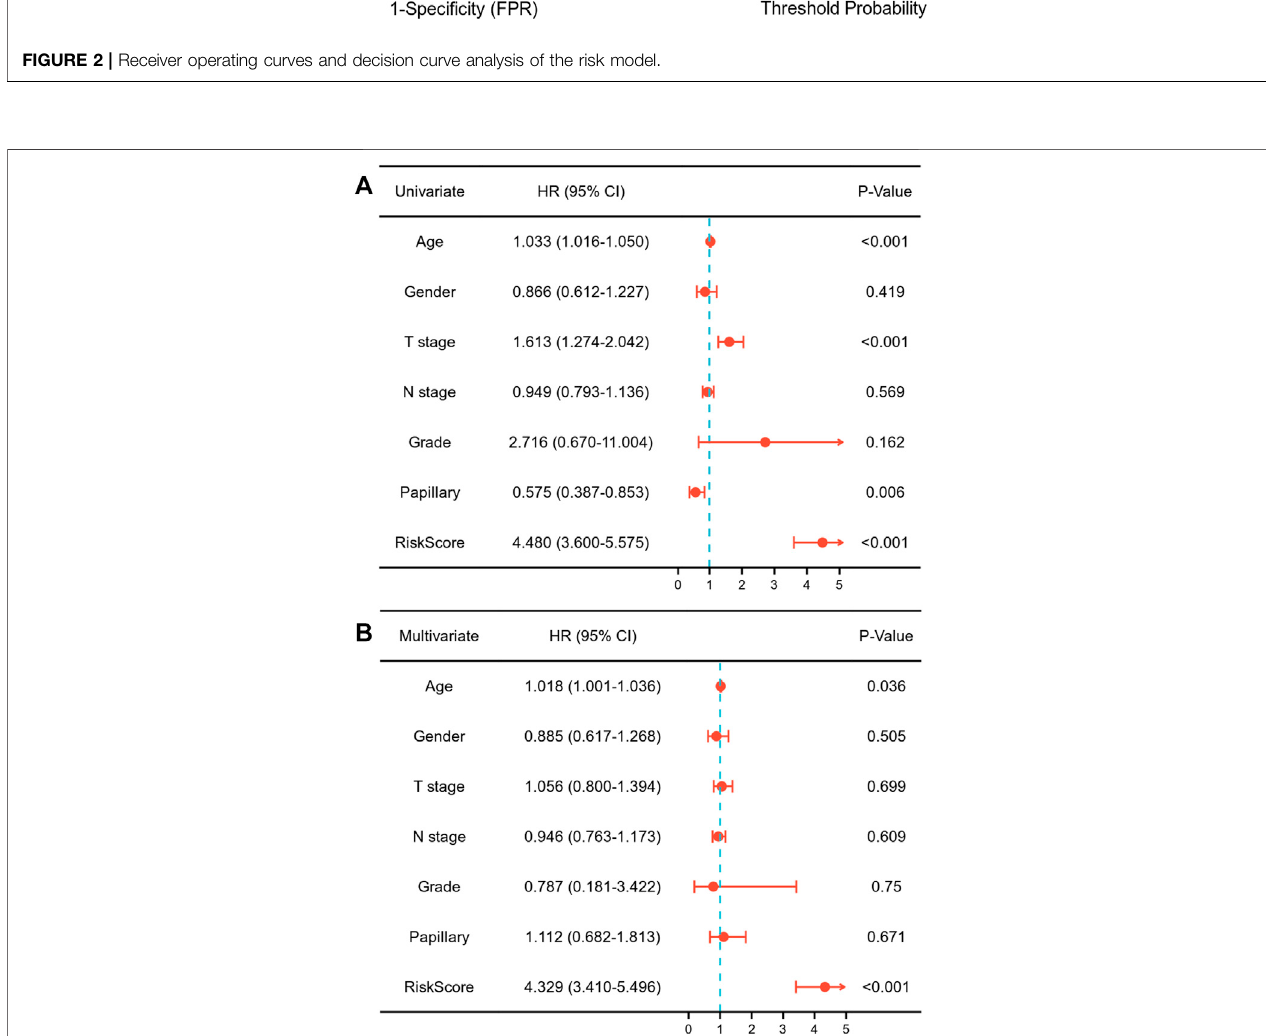
FIGURE 3 | Univariate (A) and multivariate (B) Cox regression assessing the correlation of the risk score with overall survival of muscle-invasive bladder cancer.